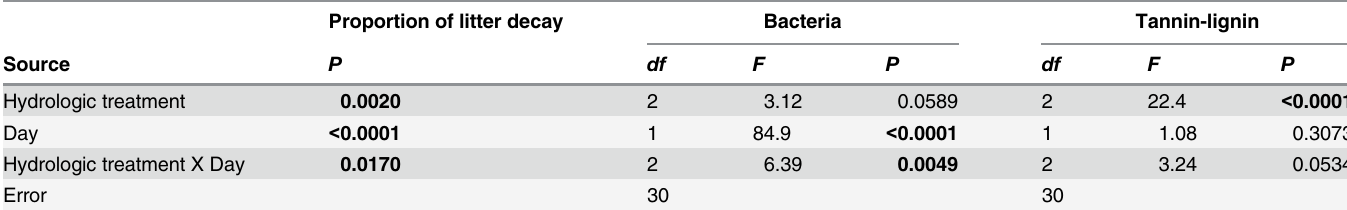
Table 1. Randomization ANOVA results for proportion of litter decay and parametric ANOVA results for log 10 transformed bacterial abundance (colony forming units, CFU/ml) and tannin-lignin concentration (mg/L) in cups exposed to one of three hydrologic treatments (dry, flooded, wet/